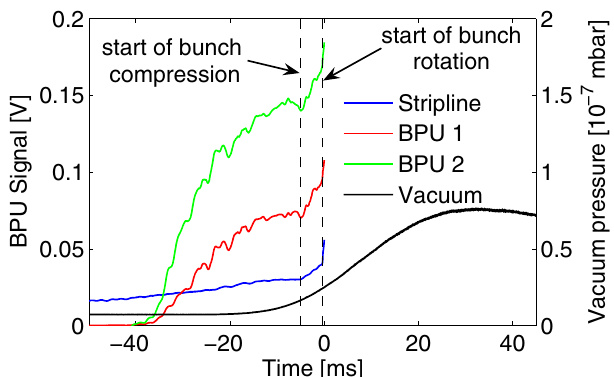
FIG. 6. (Color) The pickup signals (BPU 1 and BPU2) and the stripline peak signal (in arbitrary units) extracted from the raw data together with the vacuum pressure for the nominal LHC beam with 72 bunches. The EC becomes visible on the pickups about 40 ms before ejection, the vacuum gauge follows with a delay of about 30